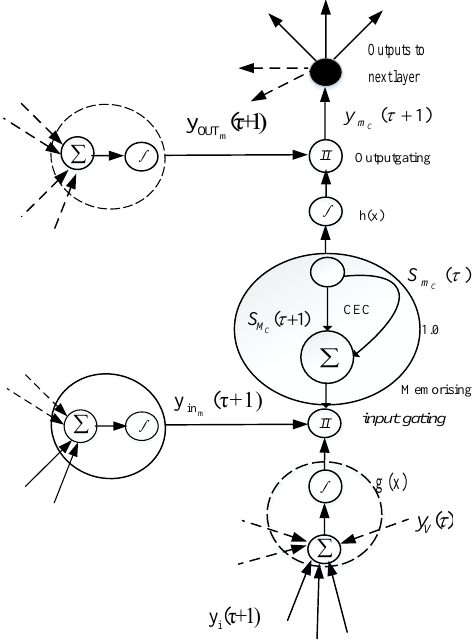
Figure 1. Structure of LSTM unit.